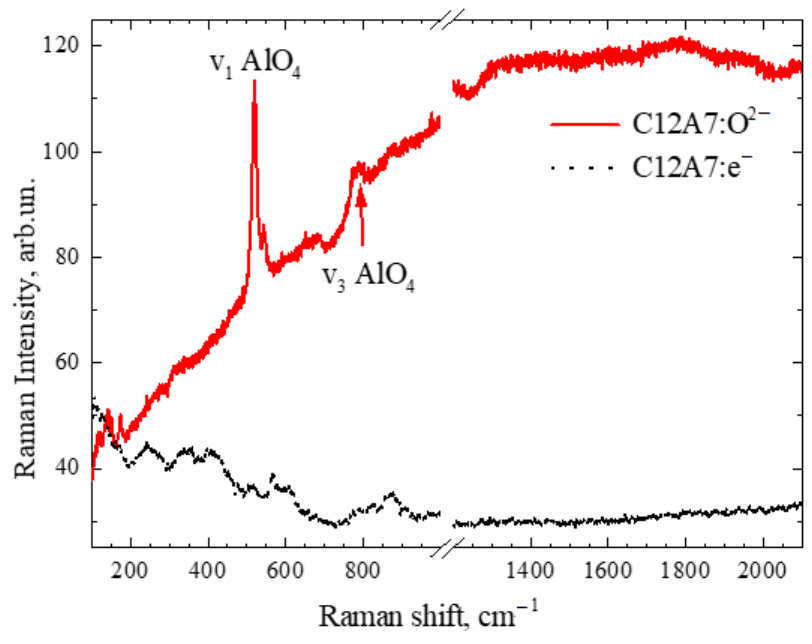
Figure 5. Raman spectra of C12A7:O 2 − ( red ) and C12A7:e − ( black ).